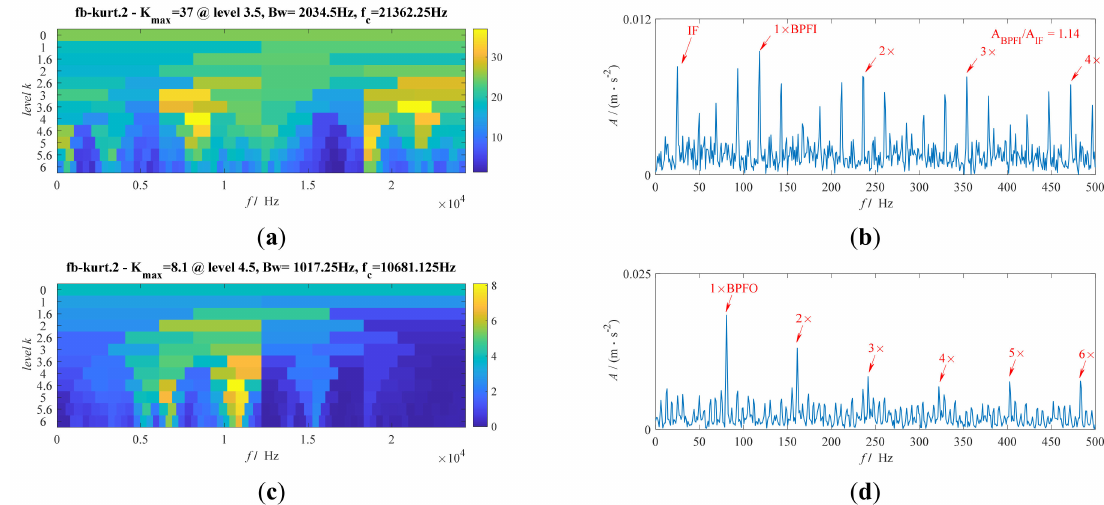
Figure 10. Results by FK for the signals from MFPT: ( a , b ) correspond to the kurtogram and SES of the inner race fault bearing; ( c , d ) correspond to the kurtogram and SES of the outer race fault bearing.